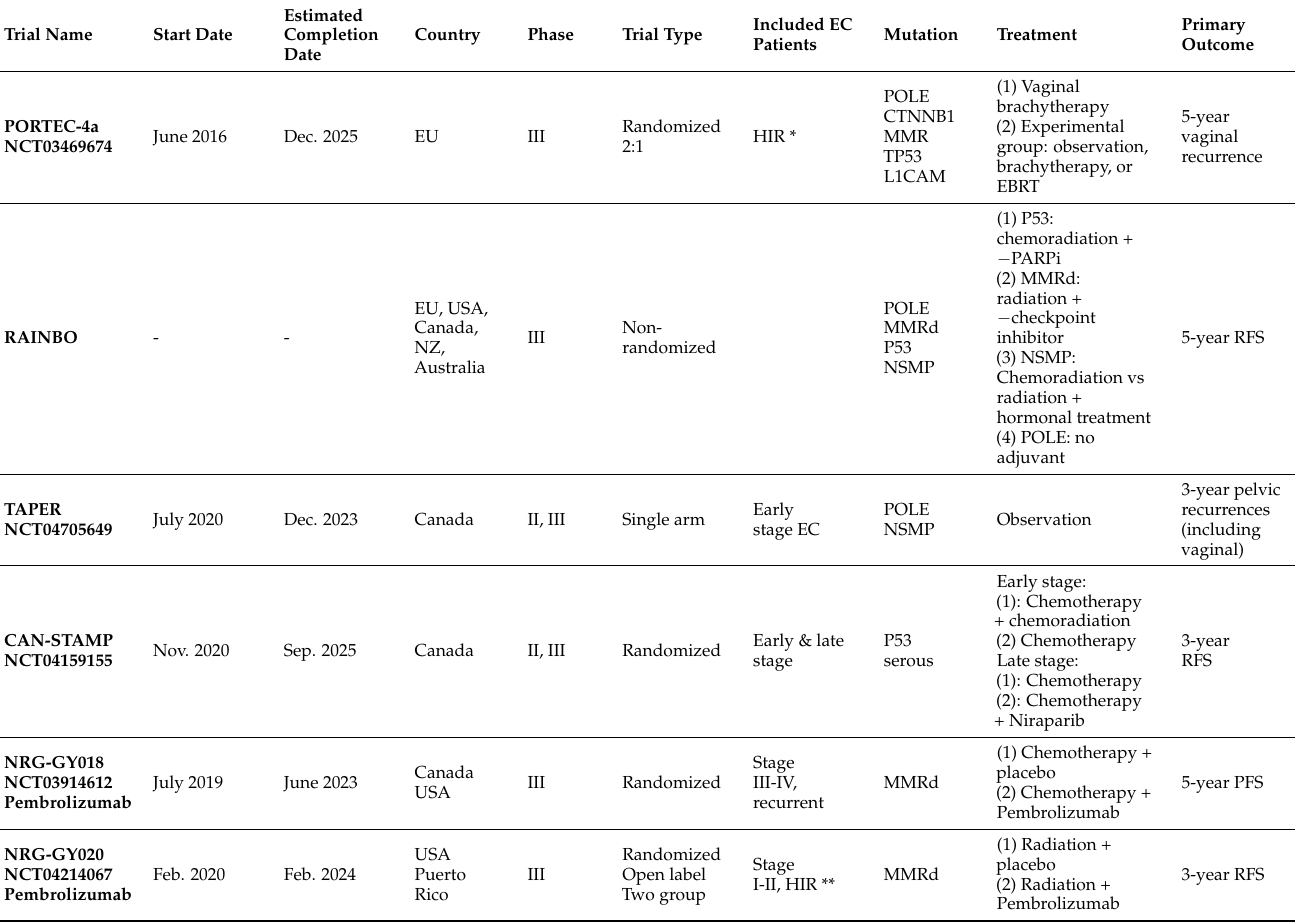
Table 3. Ongoing trials for endometrial cancer (EC) treatment based on molecular